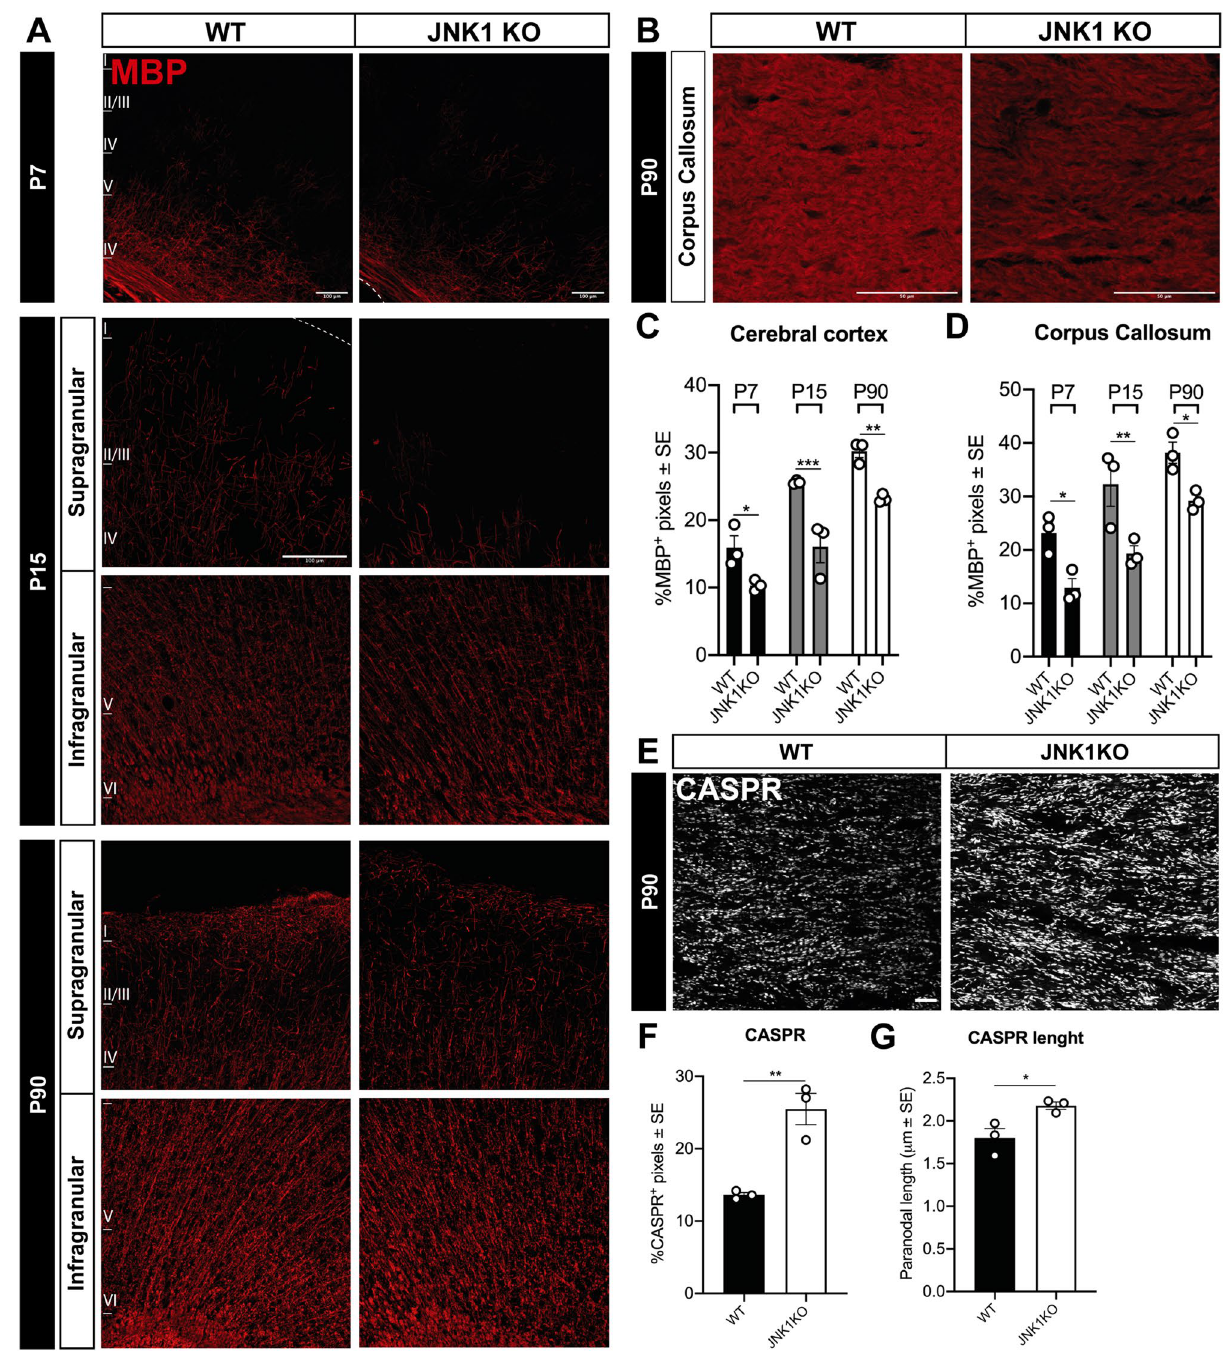
Figure 1. Myelin alterations in JNK1 KO mouse cortex and CC. ( A ) Myelin distribution (red) in the cortex of P7, P15 and P90 WT vs JNK1KO mice. At P7 images illustrate the deep layers of the somatosensory cortex, at P15 and P90 images illustrate separately infragranular and supragranular cortical layers. ( B ) Representative images of MBP (red) distribution in P90 WT vs JNK1KO mice CC. ( C , D ) Quantification of the percentage of MBP + pixels in the cortex ( C ) and in the CC ( D ) of P7, P15 and P90 WT vs JNK1KO mice. ( E ) Distribution of CASPR + paranodes in the CC of P90 WT vs JNK1KO mice, and ( F ) quantification of the percentage of CASPR + pixels. ( G ) Quantification of the length of CC CASPR + paranodes in P90 WT vs JNK1KO mice. Scale bars: 100 μm in ( A ) and ( B ), 10 μm in ( E ). WT wild type, P postnatal day, MBP Myelin Basic Protein, CASPR contactin-associated protein. *P < 0.05; **P < 0.01; ***P <